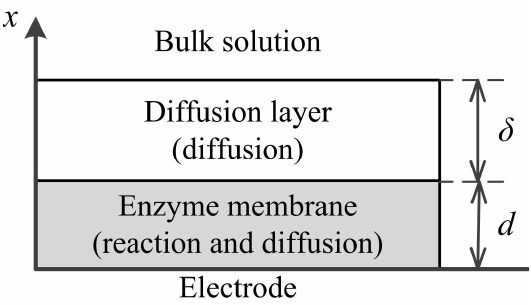
Figure 1. Principal structure of the